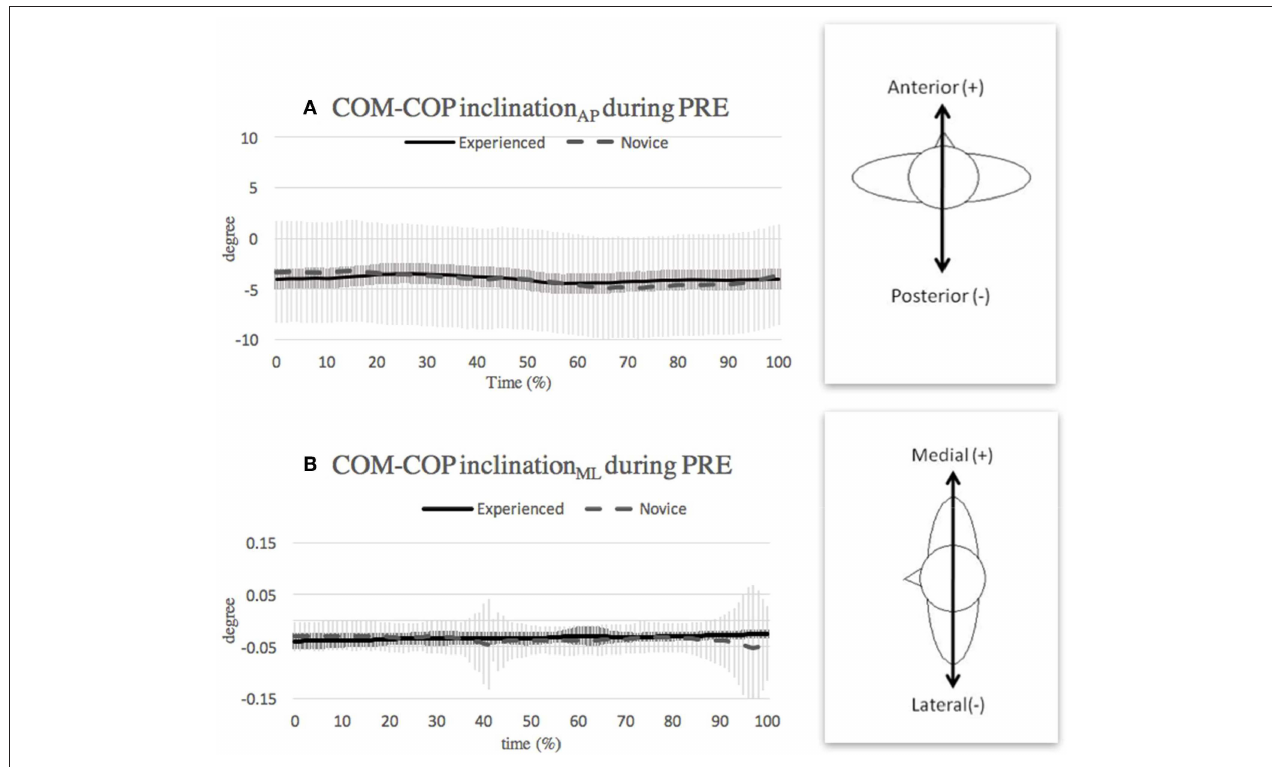
FIGURE 3 | Mean and SD of COM-COP inclination angle in (A) anterior-posterior direction and (B) medial-lateral direction during preparatory (PRE). Note that the curves show the average value obtained over the three highest-scoring trials of each individual in the respective